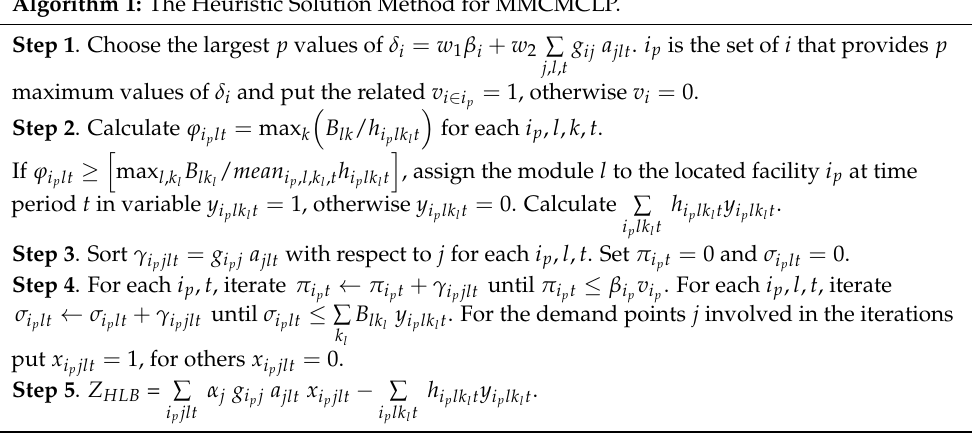
Algorithm 1: The Heuristic Solution Method for